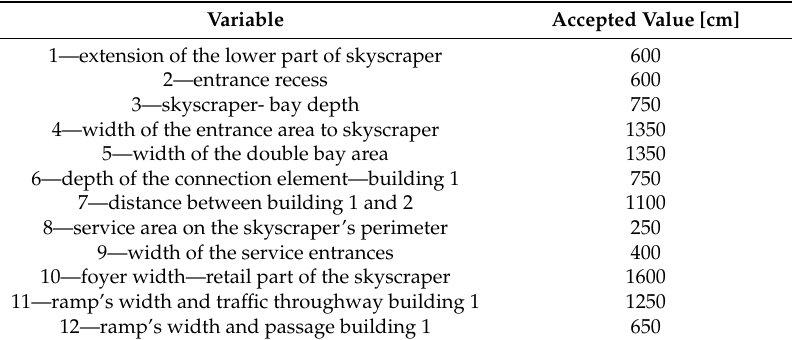
Table 6. Variables used for the algorithmic model.